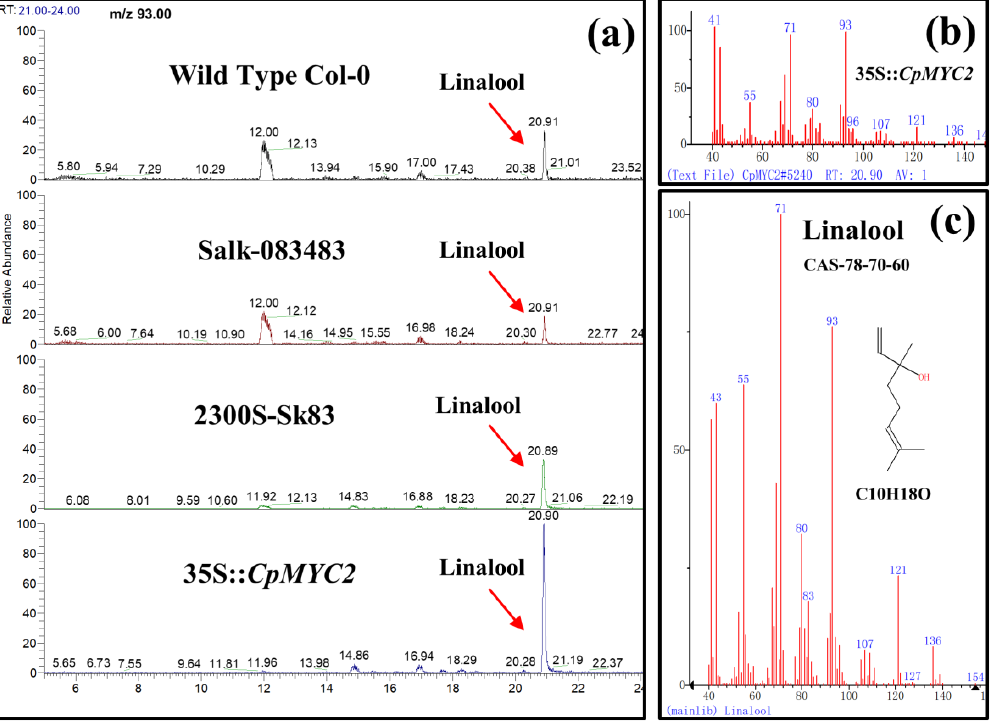
Figure 10. GC-MS analysis of linalool emitted after the application of MeJA and GA3 from the flowers of arabidopsis wild type (WT-Col-0), mutant (Salk_083483), mutant Salk_083483 transformed by the empty vector pCAMBIA2300S (2300S-Sk83), and CpMYC2 gene (35S:: CpMYC2 ) plants. ( a ) GC-MS chromatogram comparison between different plants. ( b ) Mass spectrum of the product. ( c ) Product confirmation in the NIST database according to retention index and mass spectrum.